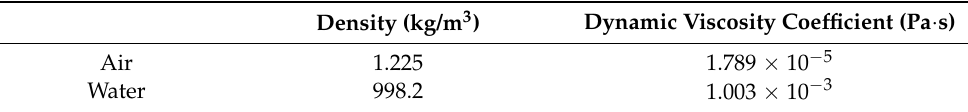
Table 1. Physical parameters of the 15 ◦ C air and 20 ◦ C